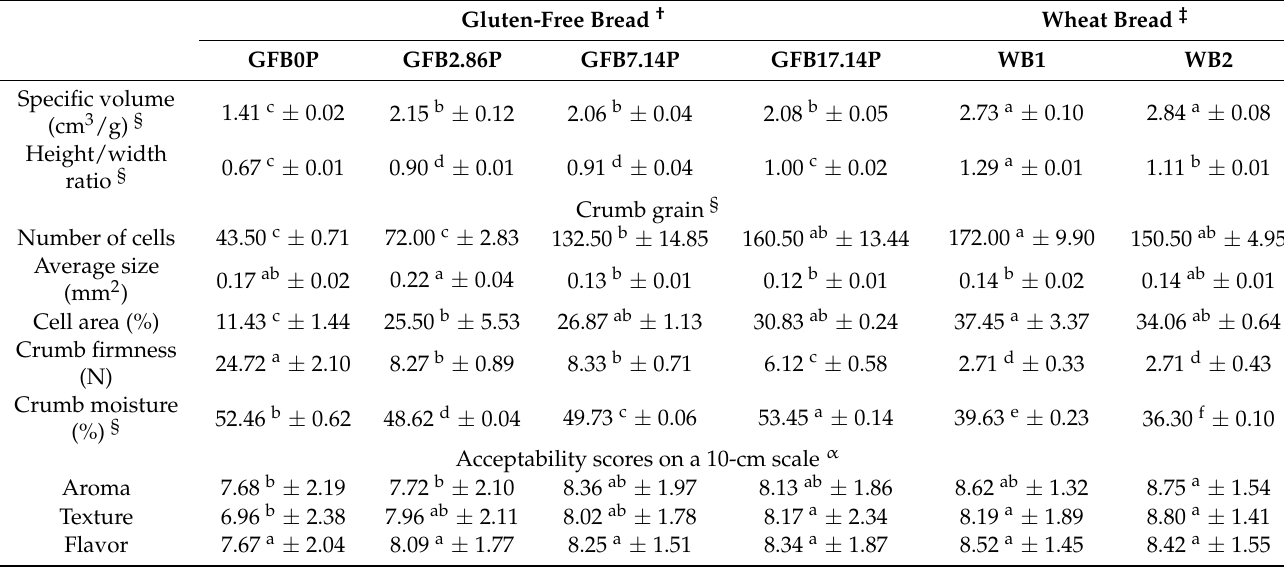
Table 1. Quality parameters of gluten-free bread formulations containing different psyllium levels and their comparison to the control and wheat bread